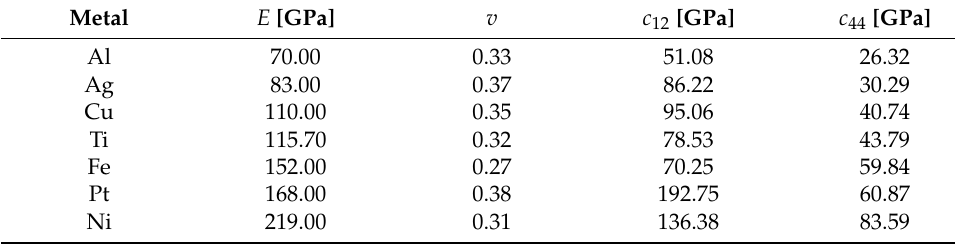
Table 2. Parameters Related to the Elasticity of Different Electrode Materials.